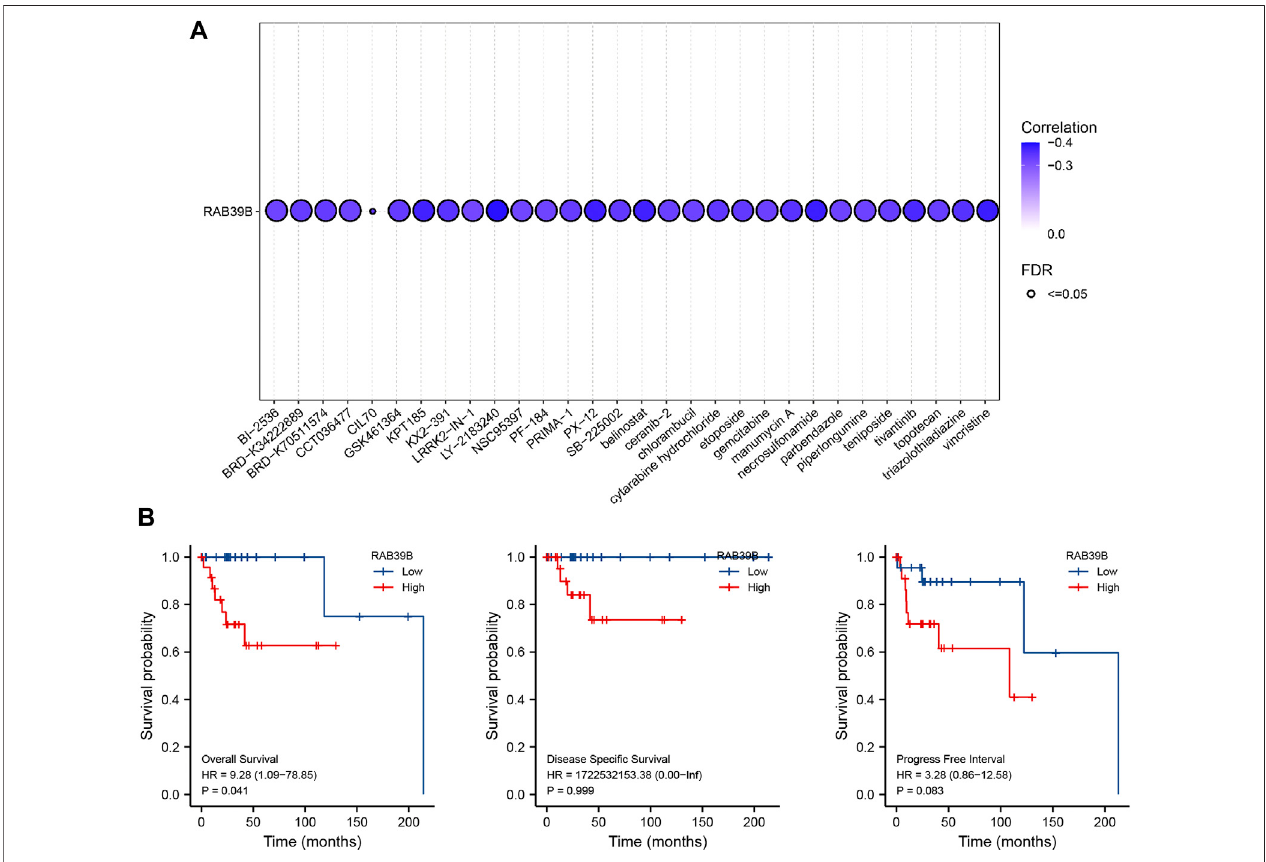
FIGURE7| Clinical signi fi canceofRAB39B expression. (A) Correlation betweenRAB39B expression and thesensitivity ofCTRP drugs(top 30) inpan-cancer. (B) Relationship between RAB39B expression and OS, DSS, and PFI using Kaplan – Meier survival analysis.